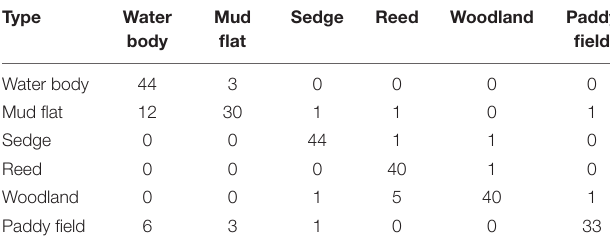
TABLE 2 | Error matrix table of classification accuracy of the Dongting Lake area in